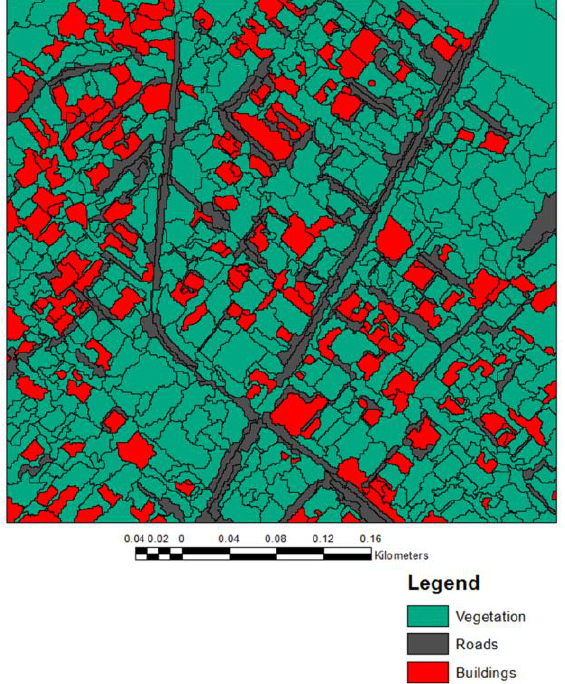
Figure 6 Classified Image using Multi-resolution algorithm